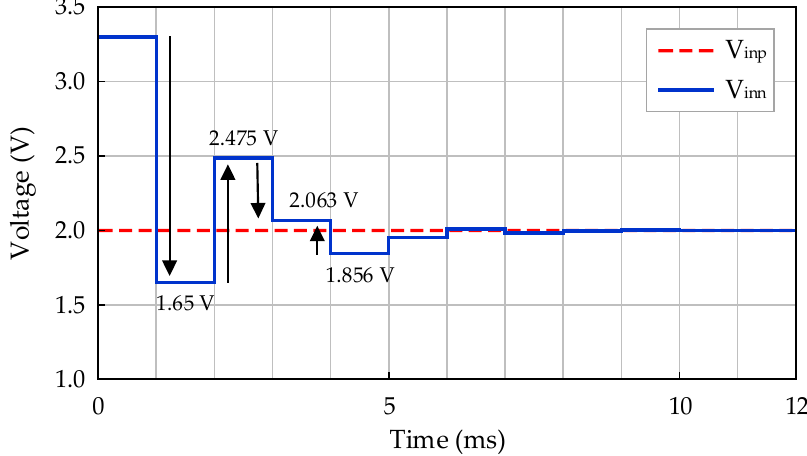
Figure 8. Operation example of AOCL.